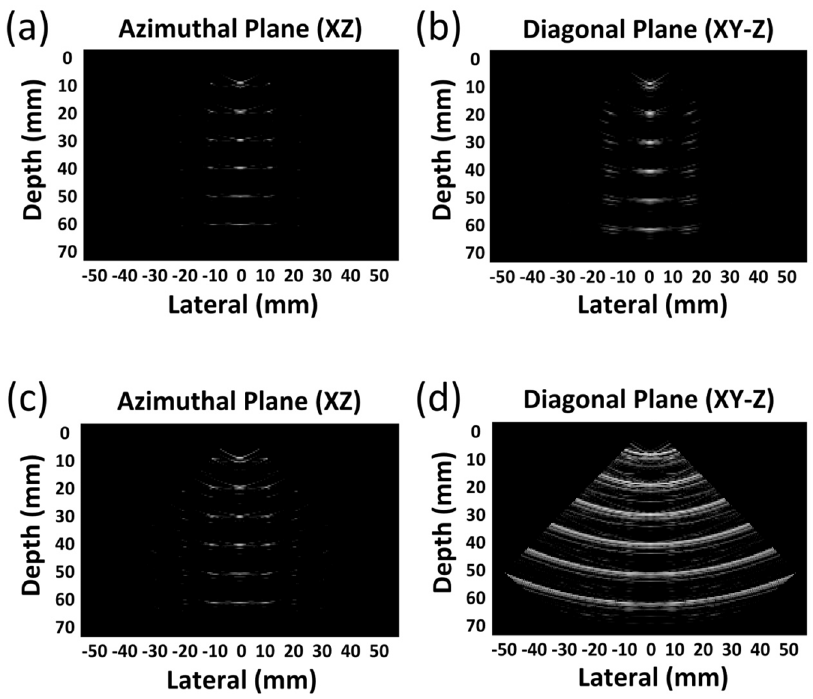
Figure 5. B-scan images acquired from unfocused FT-FR in ( a ) azimuthal and the ( b ) diagonal planes, Figure 5. B ‐ scan images acquired from unfocused FT ‐ FR in ( a ) azimuthal and the ( b ) diagonal planes, and from unfocused FT-XR in ( c ) azimuthal and the ( d ) diagonal and from unfocused FT ‐ XR in ( c ) azimuthal and the ( d ) diagonal planes.